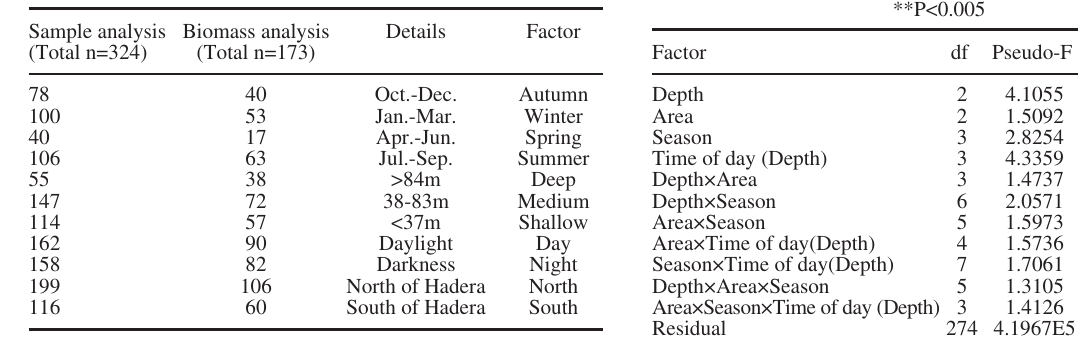
Fig . 3. – Mean landed and discarded biomass ± standard error, recorded in 173 trawl hauls for the 4 study factors: a, season; b, depth; c, time of day; and d, area. Table 2. – Number of hauls used for the analysis of sample data Table 3. – A permutation analysis of variance (PERMANOVA) (total n=324) and biomass (recorded in 173 hauls). Note that several designed to test interactions of the study factors - depth, time of day hauls may have exceeded a single time of day, depth or area and (nested in depth), area and season, and their interactions. P(perm) were thus omitted from the respective analysis. indicates the statistical significance of the interaction.